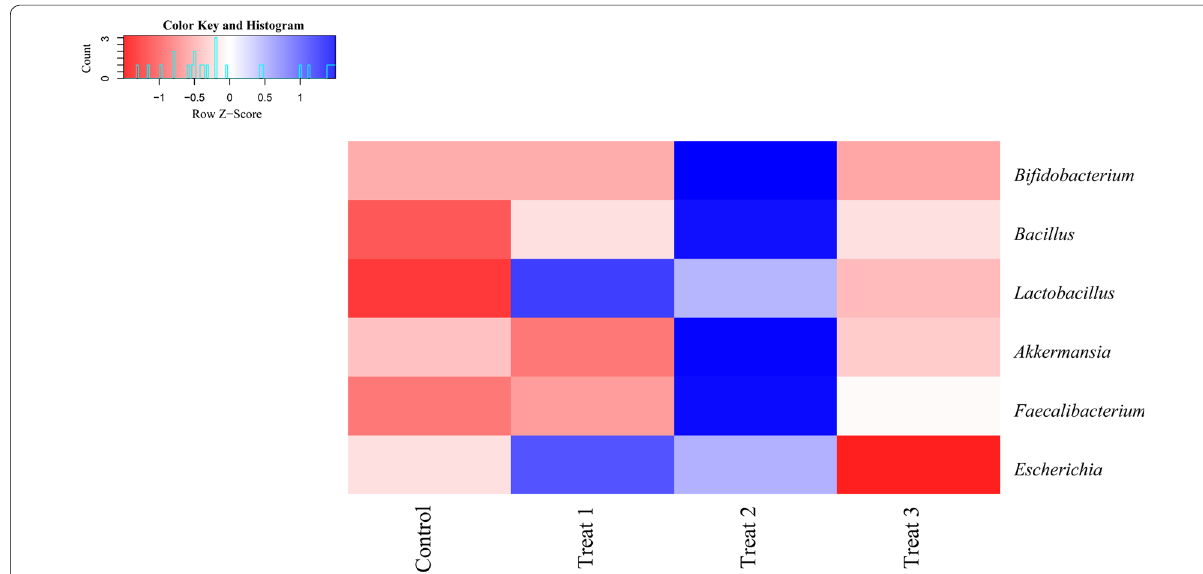
Fig. 4 The distribution of potential probiotics and pathogens of pigs among treatments. The mean relative abundance of these genera was normalized using Z-score transformation